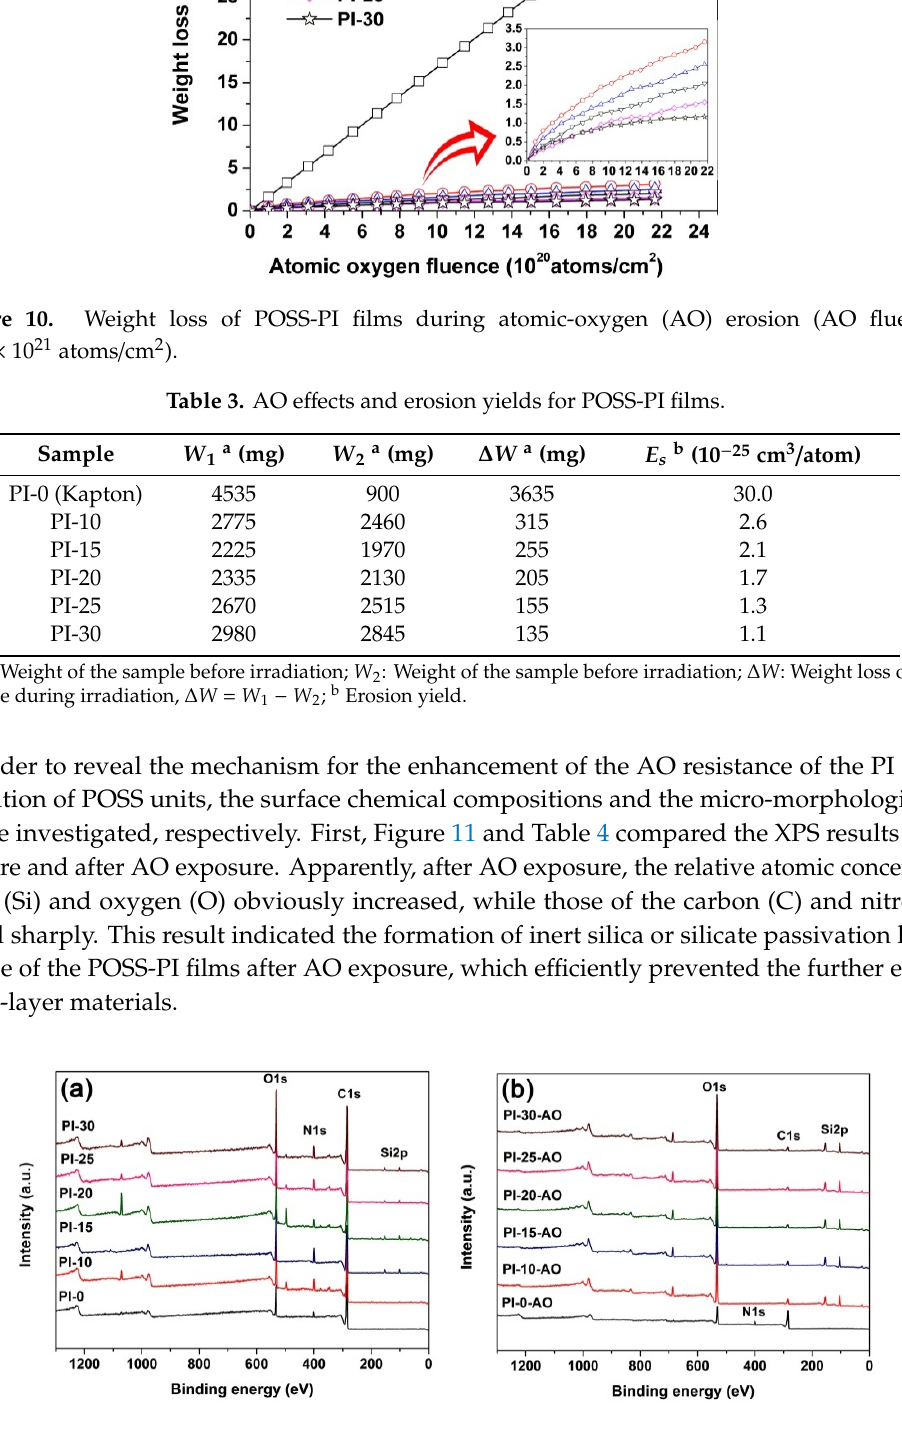
Figure 11. XPS spectra of PI films. ( a ) pristine samples; ( b ) AO ‐ exposed samples. Table 4. XPS results for the unexposed and exposed POSS ‐ PI films.